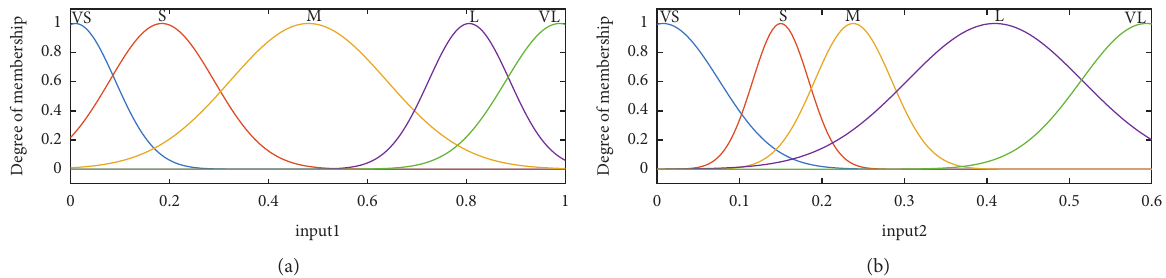
Figure 17: Membership function of the AFNN (a) SOC